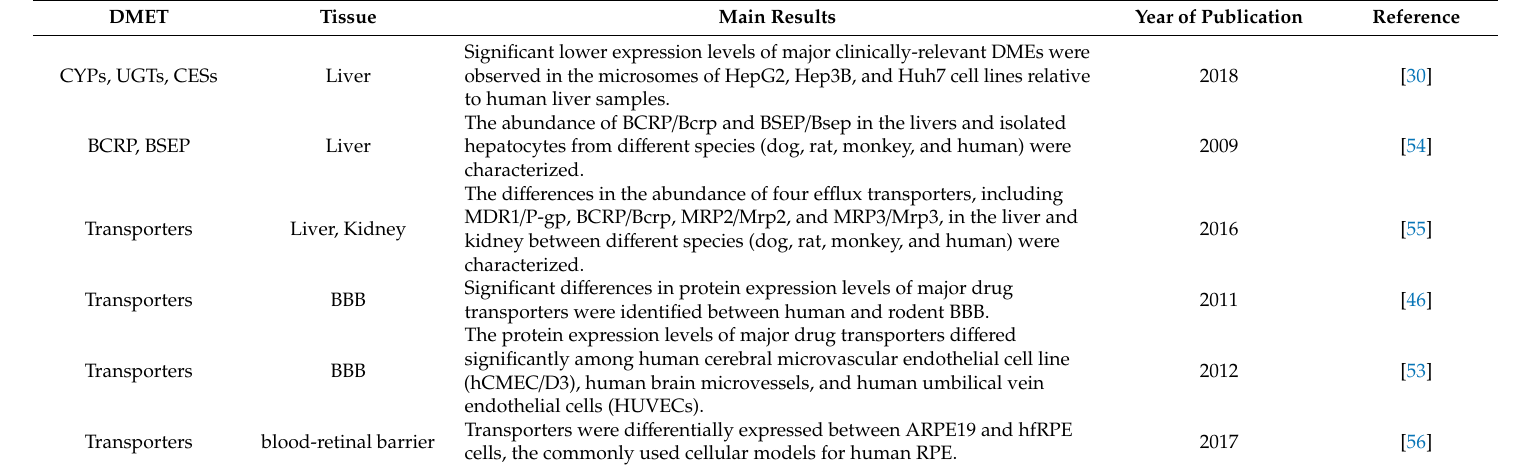
Table 2. Di ff erences in DMET abundance across species and cell